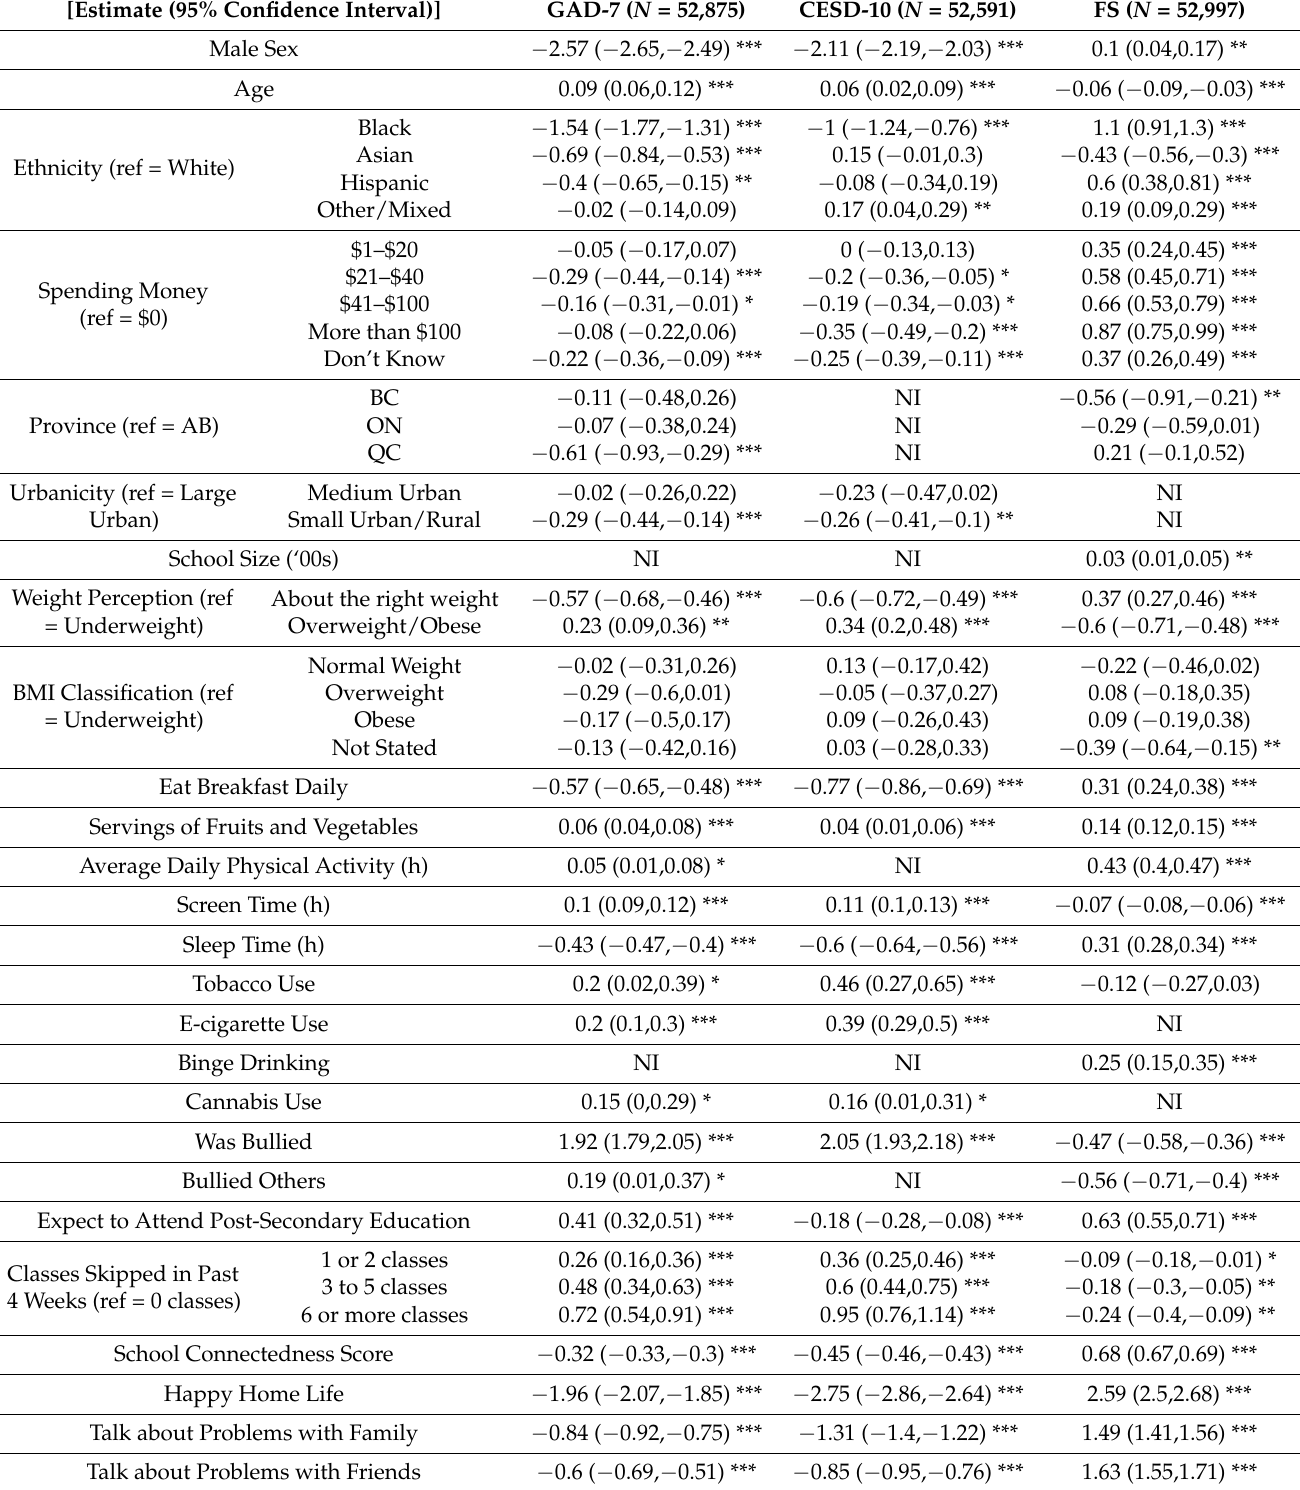
Table 2. Linear Mixed Effects Models for GAD-7, CESD-10, and FS Outcomes among students in Year 7 (2018–2019) of the COMPASS